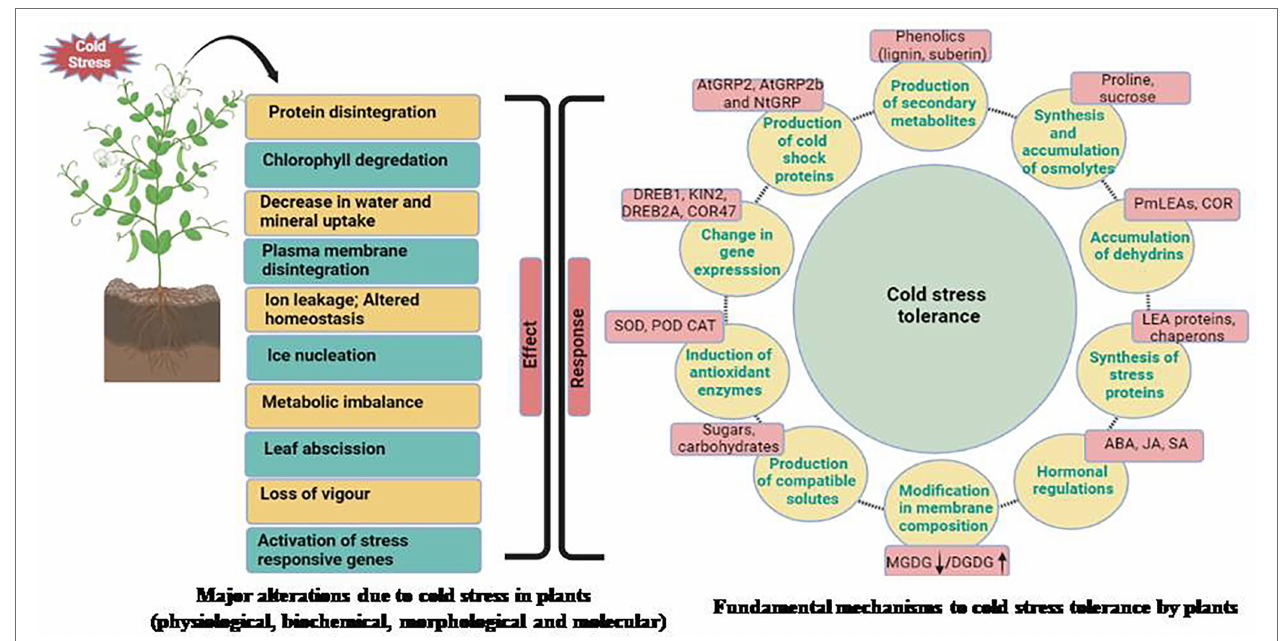
FIGURE 1 | Impact of cold stress at morphological, physiological, biochemical, and molecular levels and different mechanisms adapted by plants for combating cold